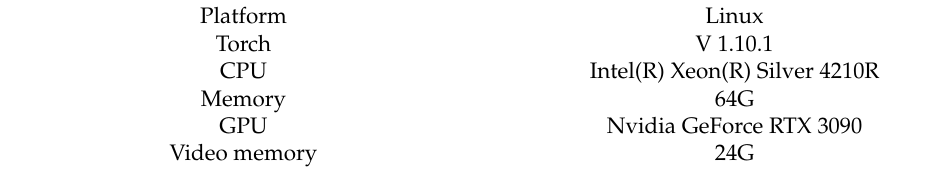
Table 4. The basic experimental environment settings.